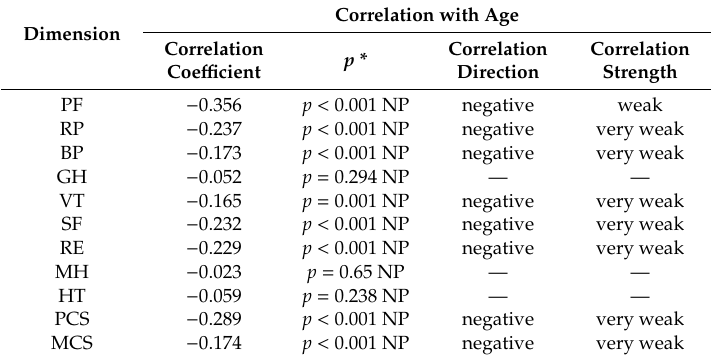
Table 5. Quality of life in individual dimensions versus age of respondents. Correlation with Age Dimension Correlation Correlation Correlation p * Direction Strength Coe ffi cient PF − 0.356 p < 0.001 NP negative weak RP − 0.237 p < 0.001 NP negative very weak BP − 0.173 p < 0.001 NP negative very weak GH − 0.052 p = 0.294 NP — — VT − 0.165 p = 0.001 NP negative very weak SF − 0.232 p < 0.001 NP negative very weak RE − 0.229 p < 0.001 NP negative very weak MH − 0.023 p = 0.65 NP — — HT − 0.059 p = 0.238 NP — — PCS − 0.289 p < 0.001 NP negative very weak MCS − 0.174 p < 0.001 NP negative very weak